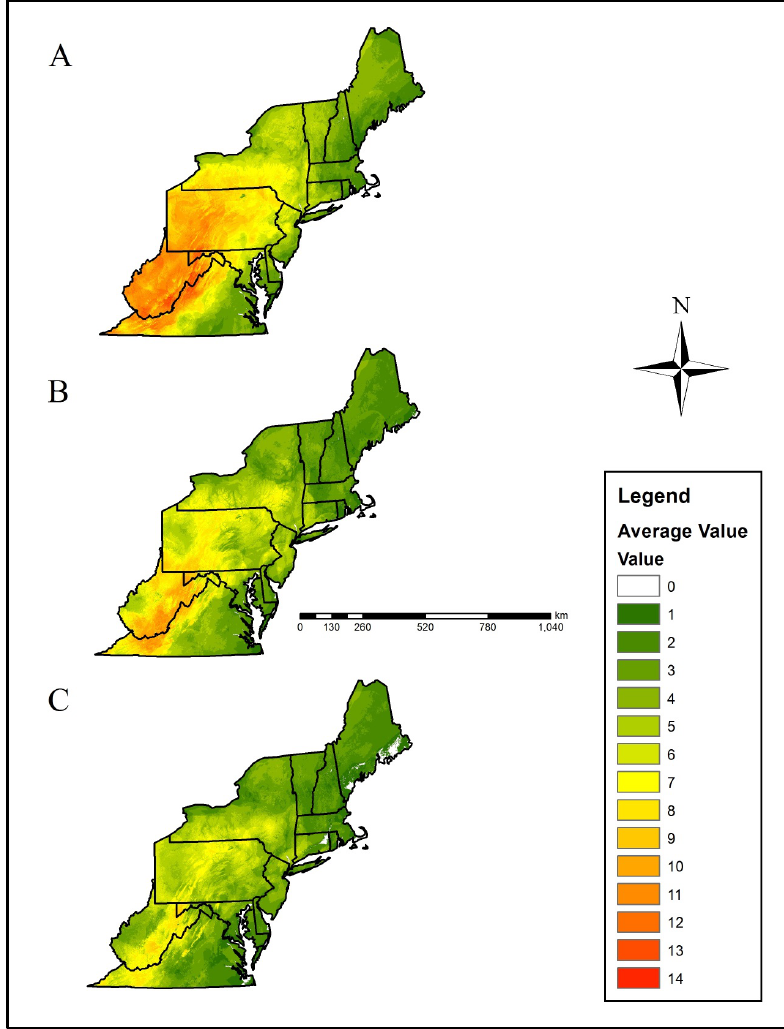
Figure 4. Mean climate refugia richness ( i.e. , number of species with a climatically-suitable niche in a landscape patch) for priority salamander species in the northeastern U.S. based on, ( A ) current climate data, ( B ) Representative Concentration Pathway (RCP) 4.5, and ( C ) RCP 8.5 projected data. Projected climatic data were derived from the CCSM4 (CCSM) and HadGEMCC-2 (Hadley) Global Climatic Models. The numerical scale indicates increasing climate refuge species richness. Please see the methods section for a detailed description of how averages were